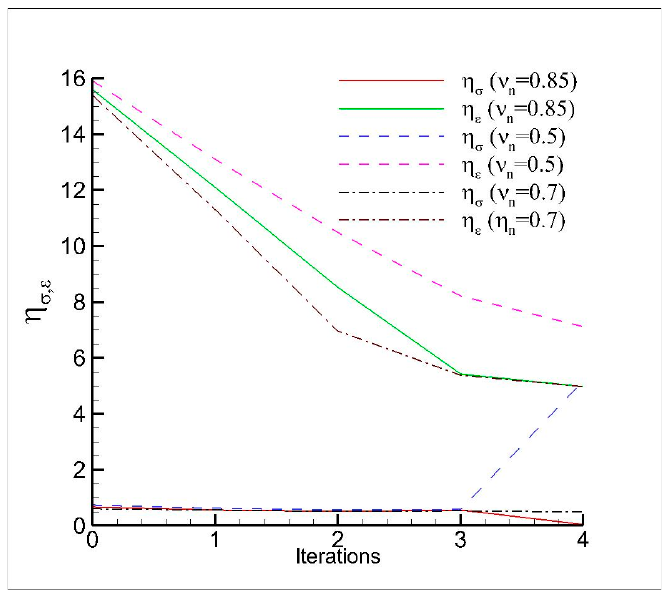
Figure 14. Global/Local performance with respect to the reference Model—comparison between Figure 14. Global / Local performance with respect to the reference Model—comparison between different levels of non–conformal meshes—Local Model 2. di ff erent levels of non–conformal meshes—Local Model 2. The configurations with (cid:2021) (cid:3041) = 0.85 and (cid:2021) (cid:3041) = 0.7 have a very similar behavior, monotonically convergent towards the Reference Model values. Considering Local Model 2, the Global/Local analyses provides accurate results after very few iterations (see also Figure 15) when the number of nodes on the Global Model side of the interface is 85% of the number of nodes on the Local Model side of the interface.